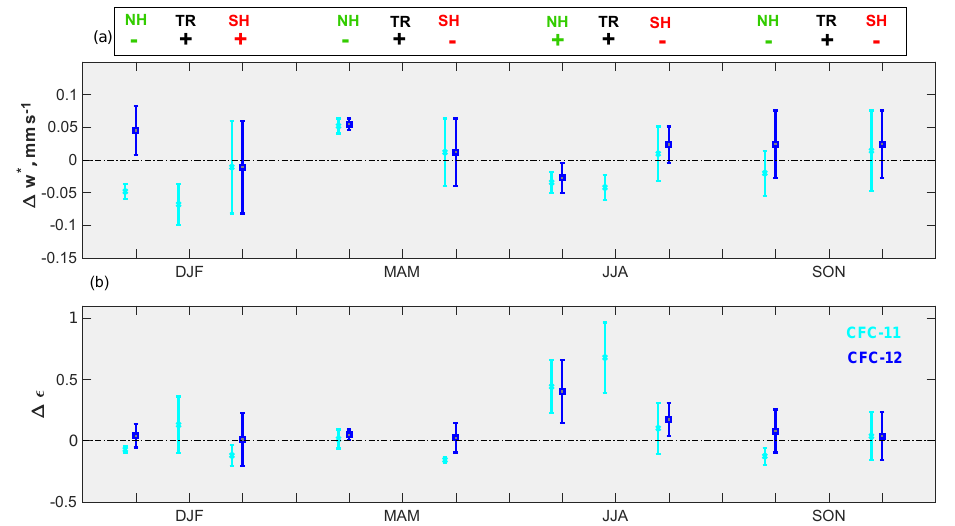
Figure 16. A summary of the TLP comparisons by season and region: panel (a) indicates the changes required in tropical upwelling, w ∗ , while panel (b) indicates the changes in the mixing, (cid:15) , required for the CMAM30HR simulation to agree with the ACE-FTS observations. The “ − ” and “ + ” symbols at the top of the figure indicate the direction of mass transport (downwelling or upwelling, respectively) for each season and region (green for Northern Hemisphere, black for tropics, and red for the Southern Hemisphere). The changes required based on CFC-11 are shown in cyan and the changes required based on CFC-12 are shown in